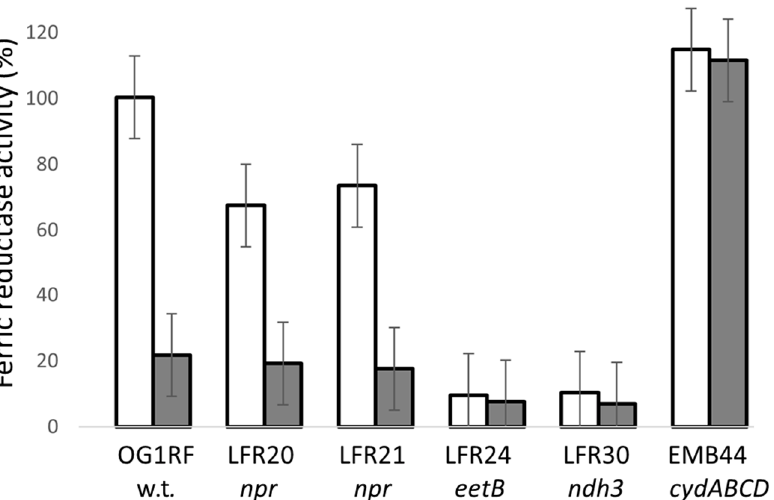
Figure 3. Ferric reductase activity of washed cells. The bacteria were grown in TSBG (open bar) or TSBG supplemented with 8 µ M hemin (filled bar). The activity for each strain and growth condition was determined in at least two independent experiments and with two measurements per sample.